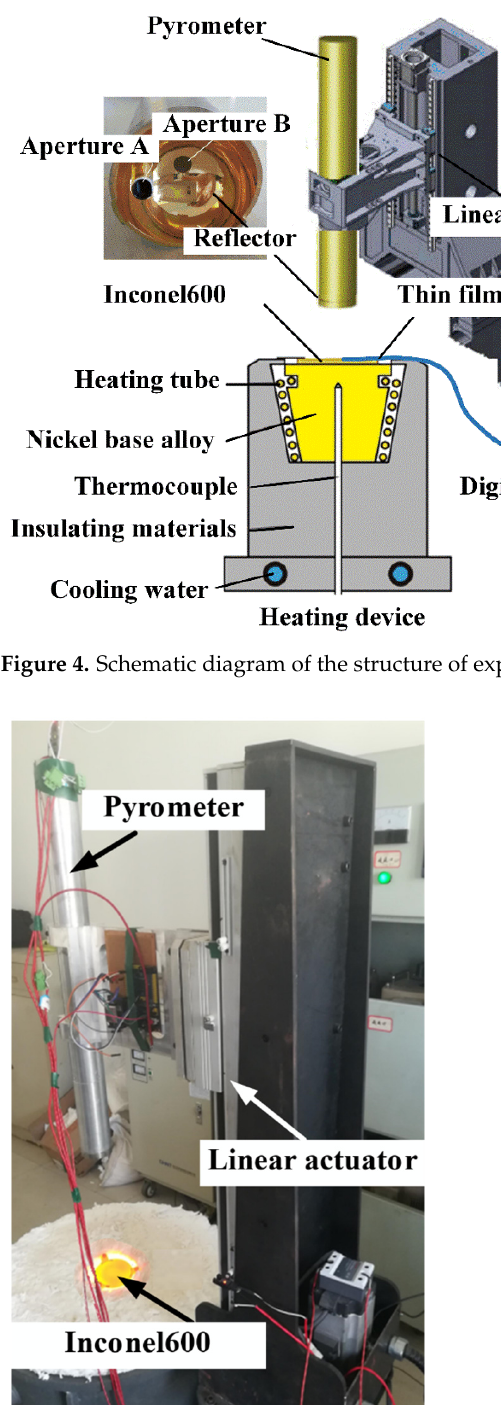
Figure 5. The photo of experimental device of emissivity measurement.